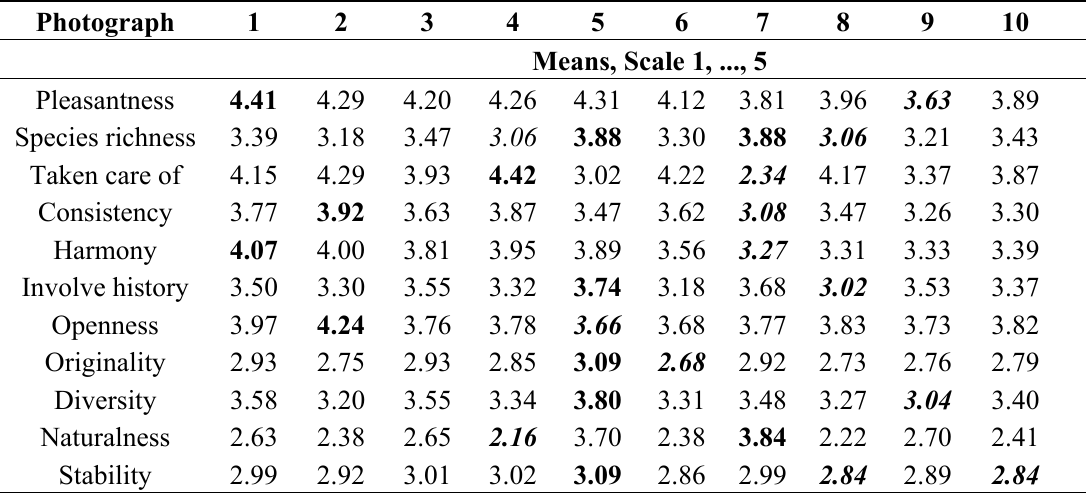
Table 1. Descriptive statistics of the key visual concepts measured on a scale from 1 (low) to 5 (high). The differences between photographs were statistically significant for all the measured concepts according to the F -test ( p <